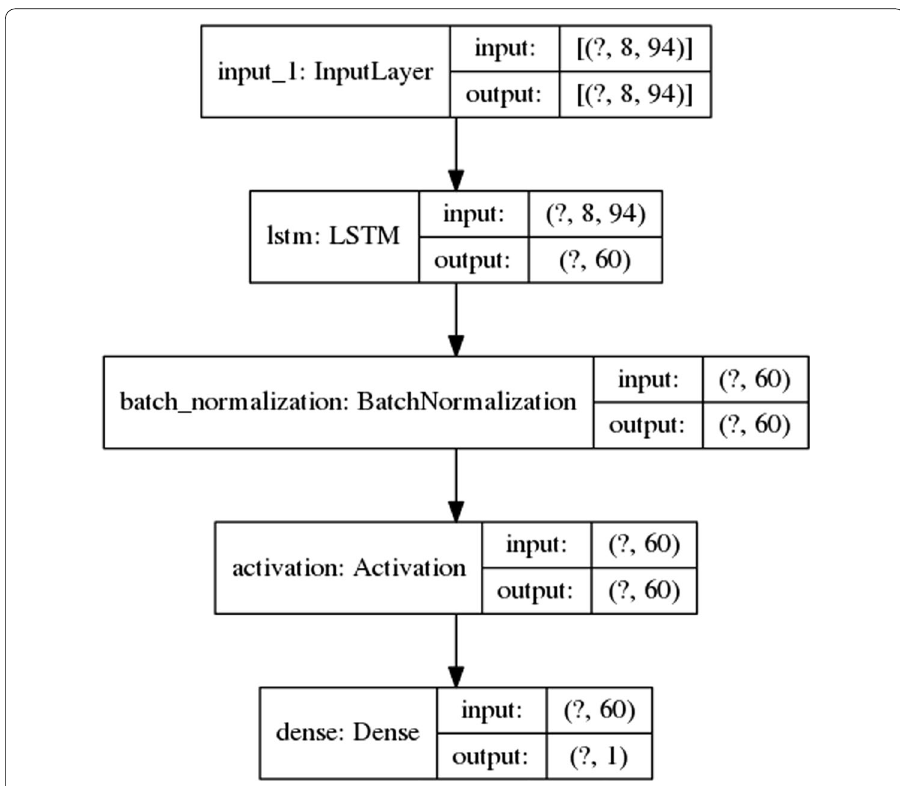
Fig. 3 Graphical view of LSTM basic